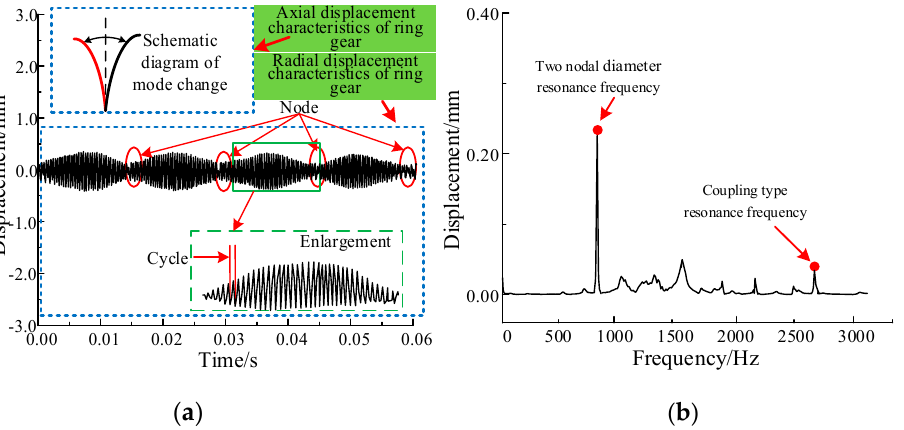
Figure 10. Radial displacement response of rim of L-shaped flexible ring gear. ( a ) Radial displacement response and ( b ) spectrum of radial displacement response.